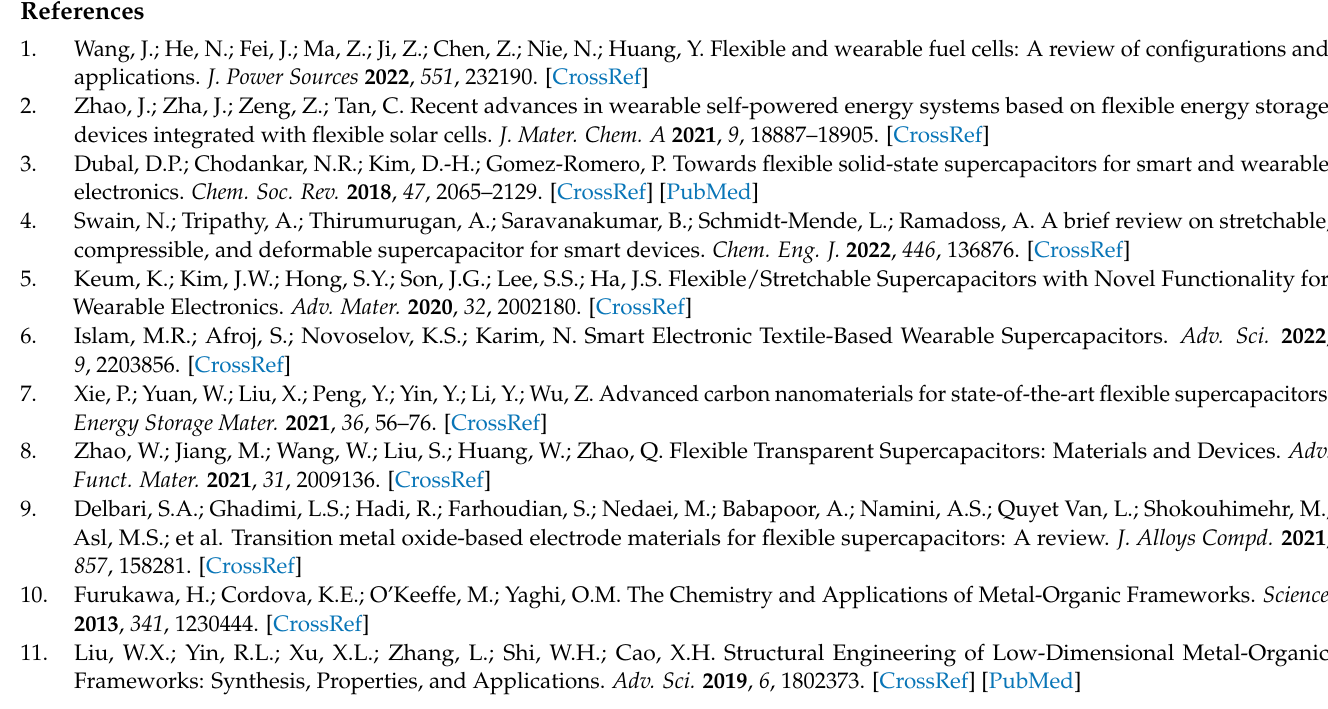
nanosheets, Figure S2. The XRD pattern of the Ti 3 C 2 T x , Figure S3. FT-IR pattern of (a) Ti 3 C 2 T x and (b) Ni-MOF, respectively, Figure S4. The pore size distribution of Ni-MOF/Ti 3 C 2 T x , Figure S5. XPS spectra of Ni-MOF/Ti 3 C 2 T x , Figure S6. High-resolution O 1s spectra of Ti 3 C 2 T x , Ni-MOF, Ni-MOF/Ti 3 C 2 T x , respectively, Figure S7. Comparation of rate capacitance of Ni-MOF/Ti 3 C 2 T x , with different growth conditions, Figure S8. Comparation of energy density of Ni-MOF/Ti 3 C 2 T x , with different growth conditions, Figure S9. Energy density at different Power density of Ni-MOF/Ti 3 C 2 T x , Figure S10. The EIS test of the Ni-MOF/Ti 3 C 2 T x before and after stability test, Figure S11. Energy density at different Power density of Ni-MOF/Ti 3 C 2 T x , Figure S12. The CV test under original or bending